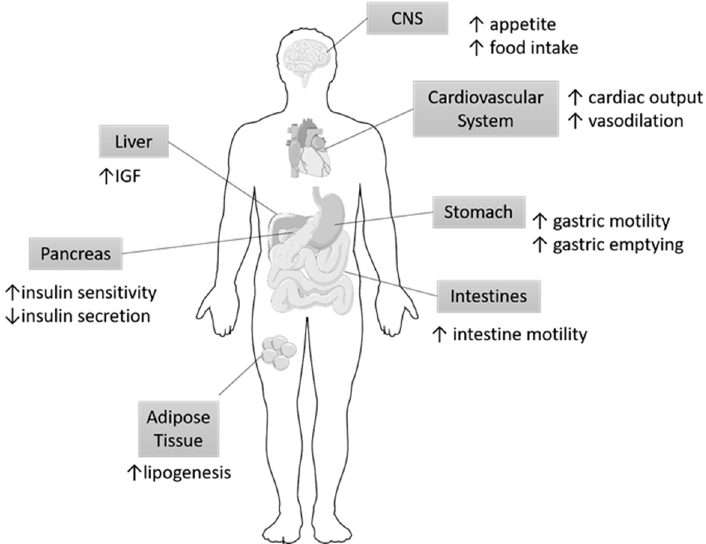
Figure 5. Organ specific targets of Ghrelin. Ghrelin has been shown to exert its action on multiple organs. Most notably, ghrelin modulates eating habits and has been correlated with metabolic syndrome. The arrows indicate the respective increase or decreases in specific functions of the organs participating in metabolism in response to Ghrelin. IGF, Insulin growth factor; CNS, central nervous